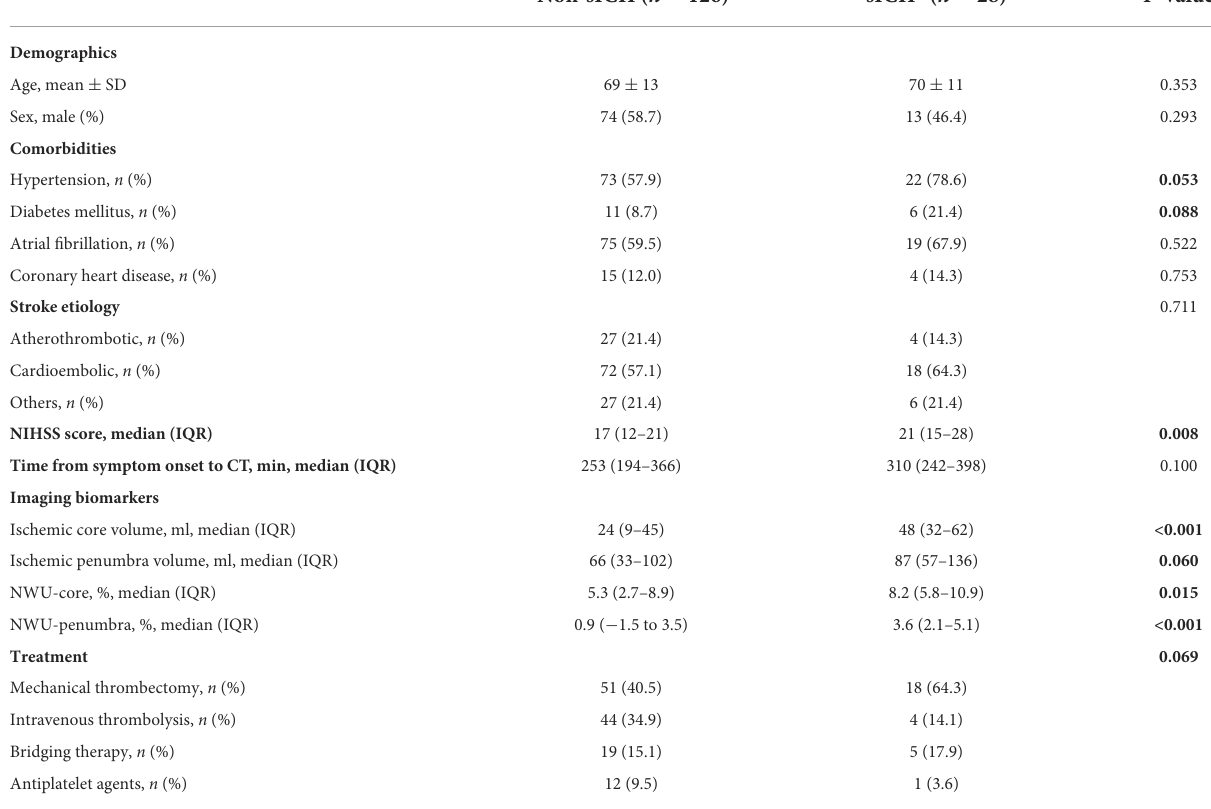
TABLE 1 Baseline characteristics of enrolled